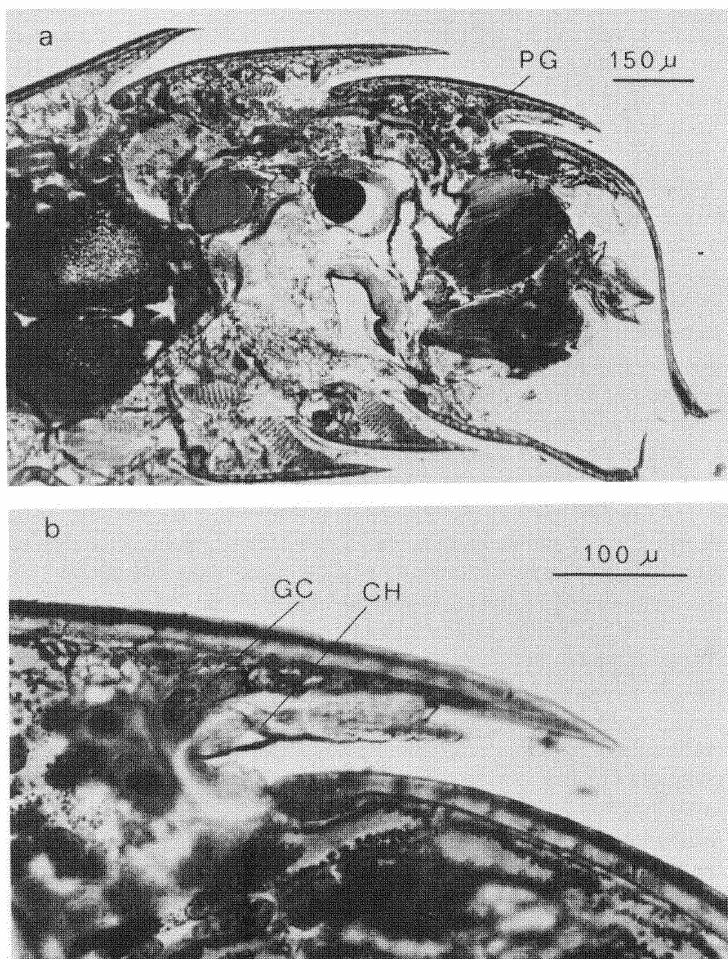
Figure 9. (a) Longitudinal section through the gaster of a Cerapachys worker showing the location of the pygidial gland (PG). (b) Longitudinal section through the pygidial gland; GC: glandular cells; CH: glandular channels through inter- egmental